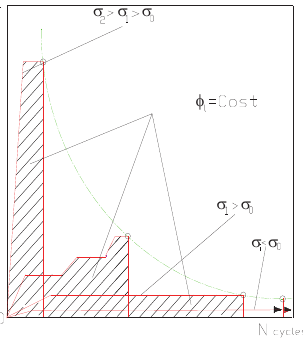
) Fig. 2 . Stress-strain and temperature i